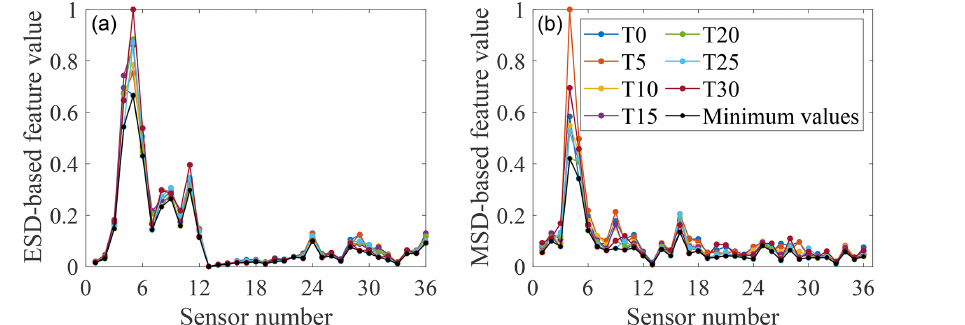
Figure 7. Feature-bagging results based on ESD (a) and MSD (b) for the damage case with M1 added. Seven controlled temperatures T 0– T 30 and the minimum value among the features for seven different temperatures are shown by colour markers.